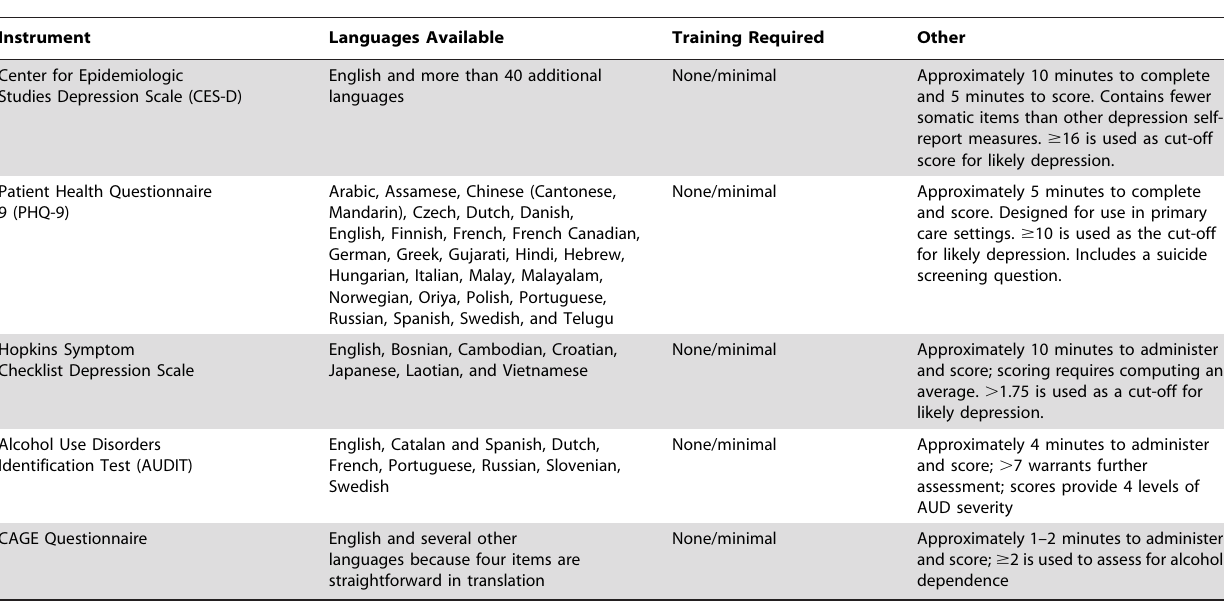
Table 1. Standardized Depression and Alcohol Use Disorder Screening Tools, Training Required, and Administration Time.